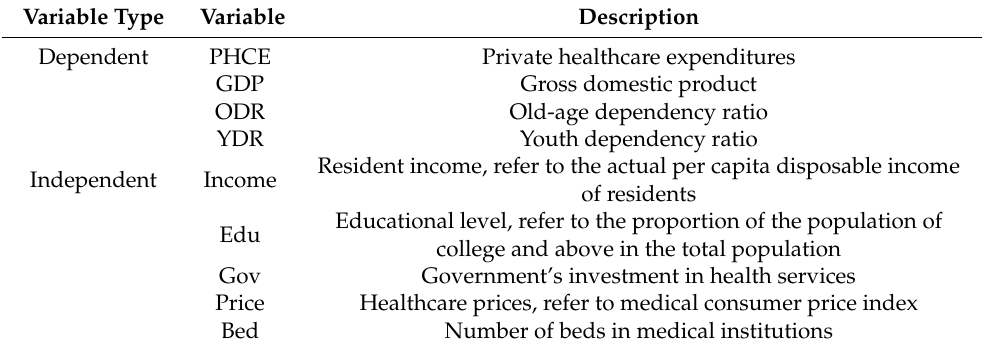
Table 1. Assignment of